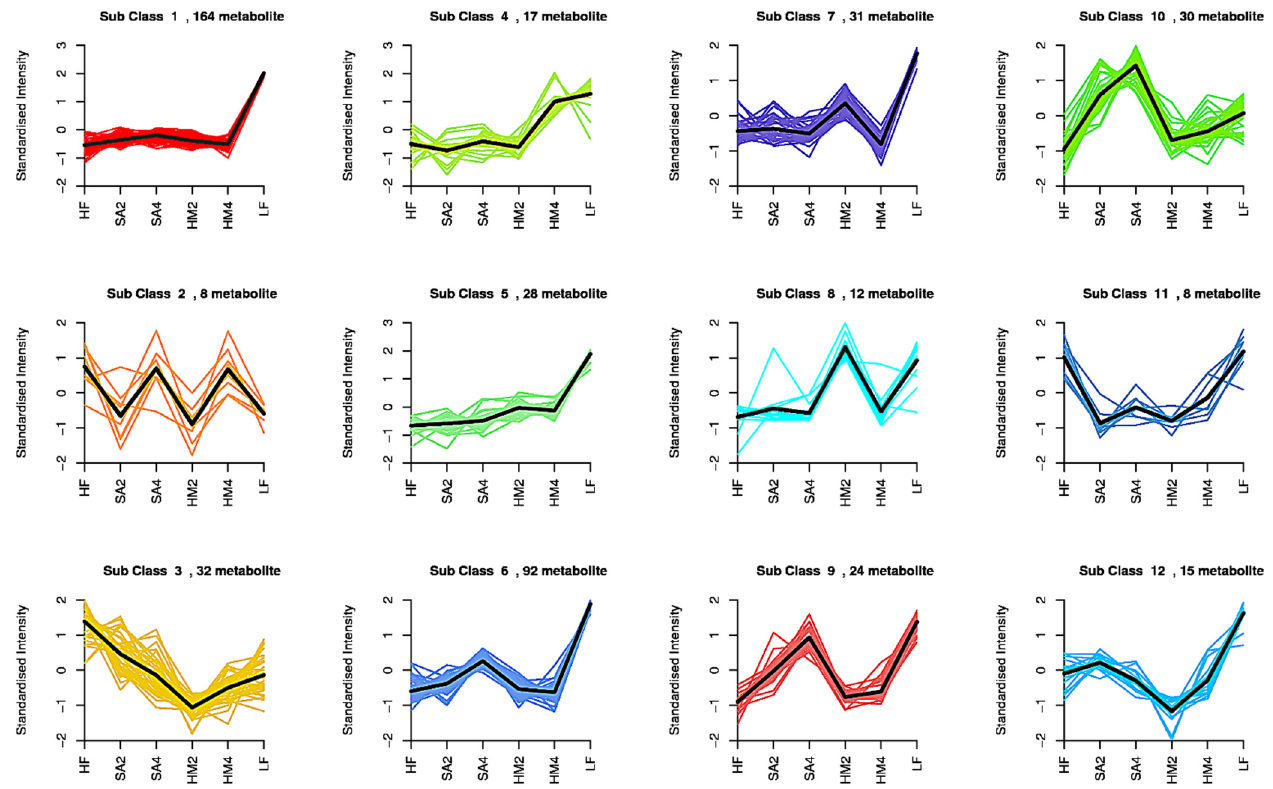
Figure 6. Overview of the K-means. The 461 lipids have been divided 12 means clusters. The abscissa represents different conditions, and the ordinate indicates different standardized intensity. The black line means the trend line in the group. Subclass in figures indicate means cluster.